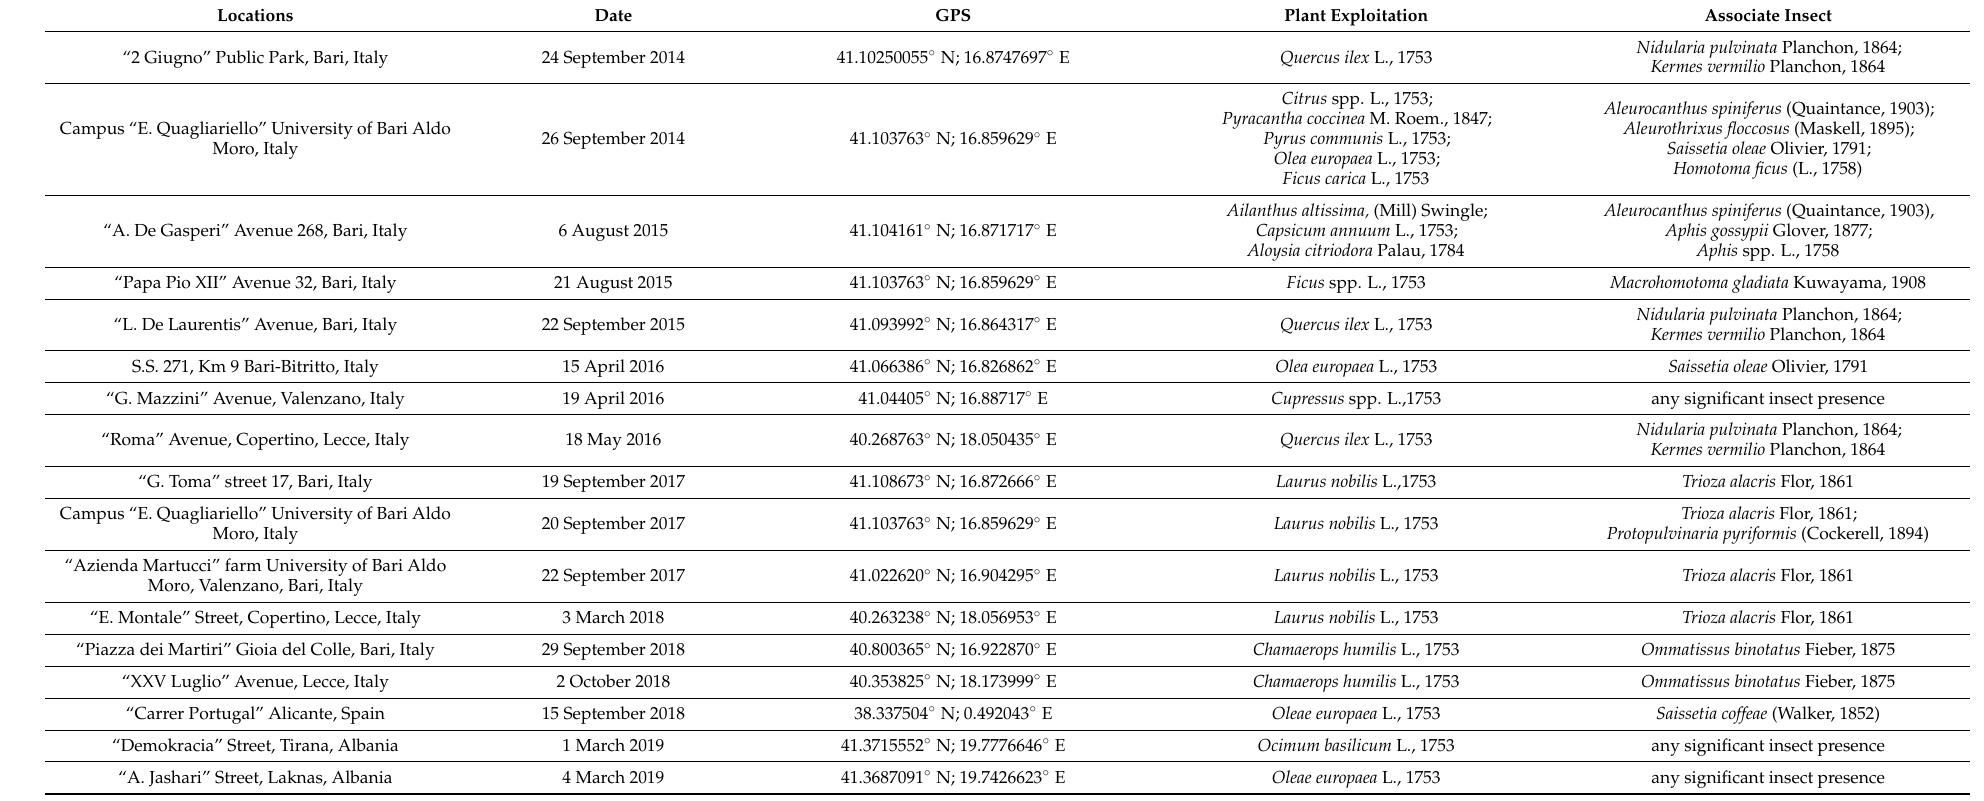
Table 1. Zelus renardii field survey in southern: Italy, Albania, and